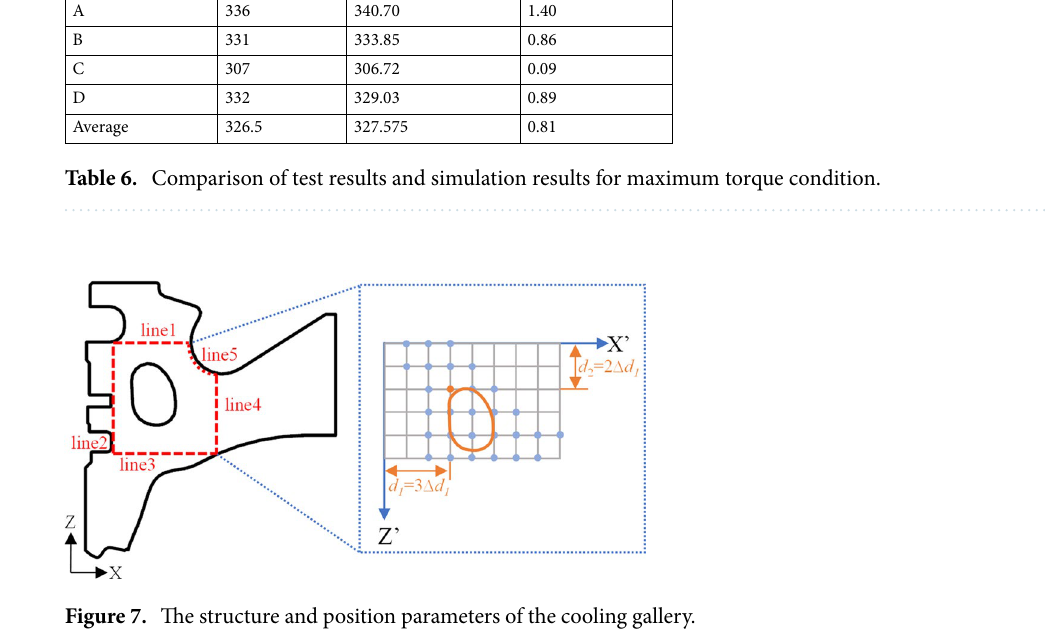
Figure 6. Comparison of test results and simulation results under the ( a ) cold start condition, ( b ) urgent acceleration condition and ( c ) rapid deceleration condition. Measuring point